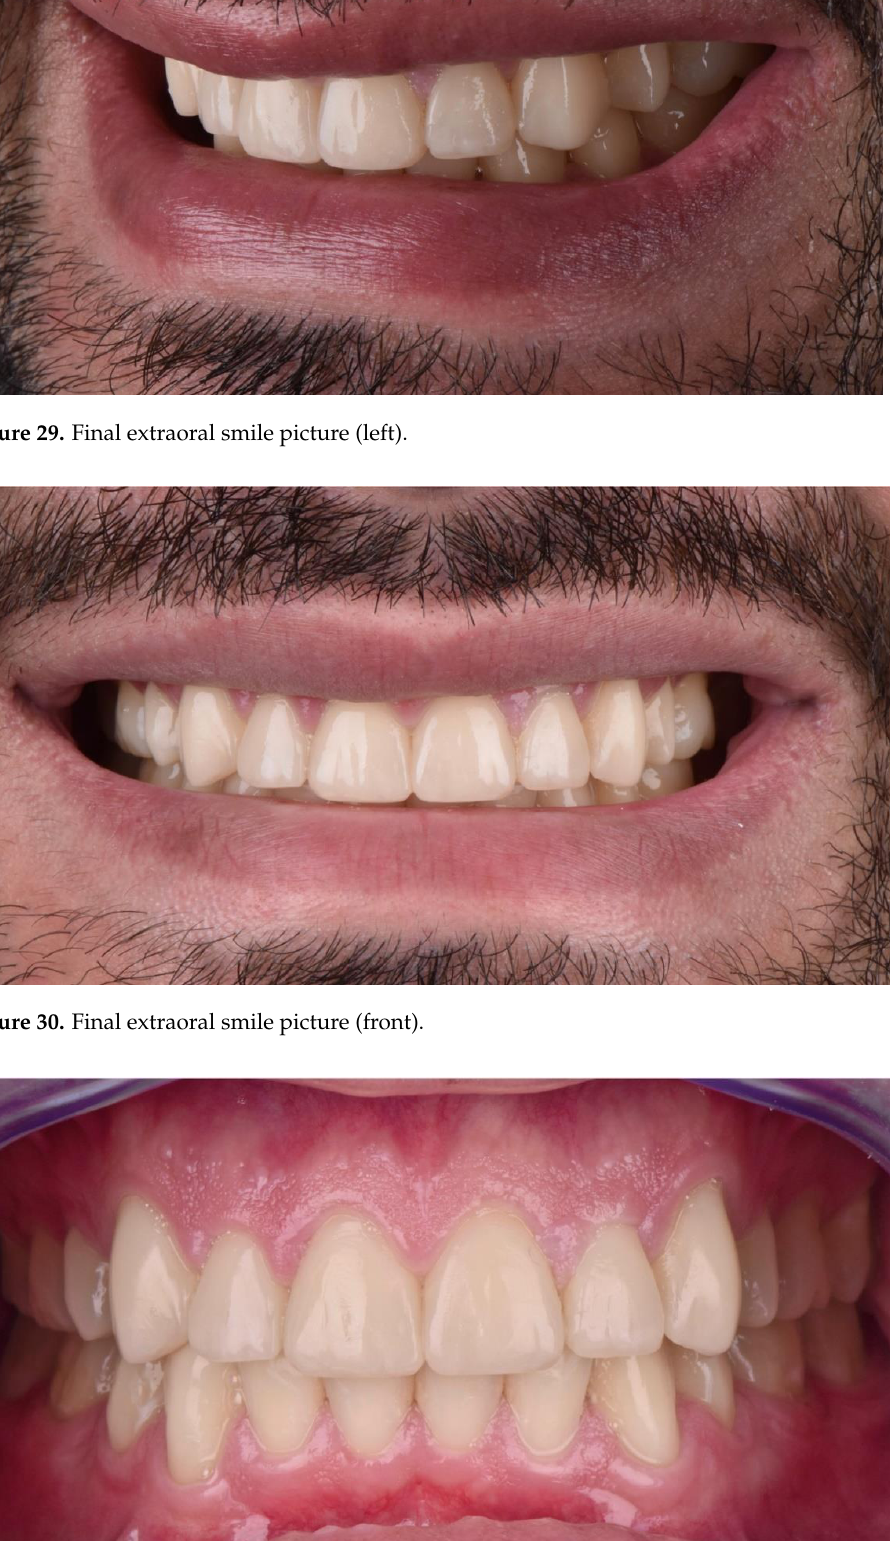
Figure 31. Final intraoral picture (front).